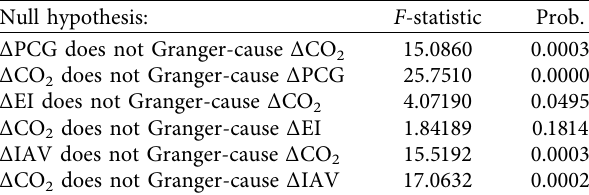
Table 8: Granger causality test.